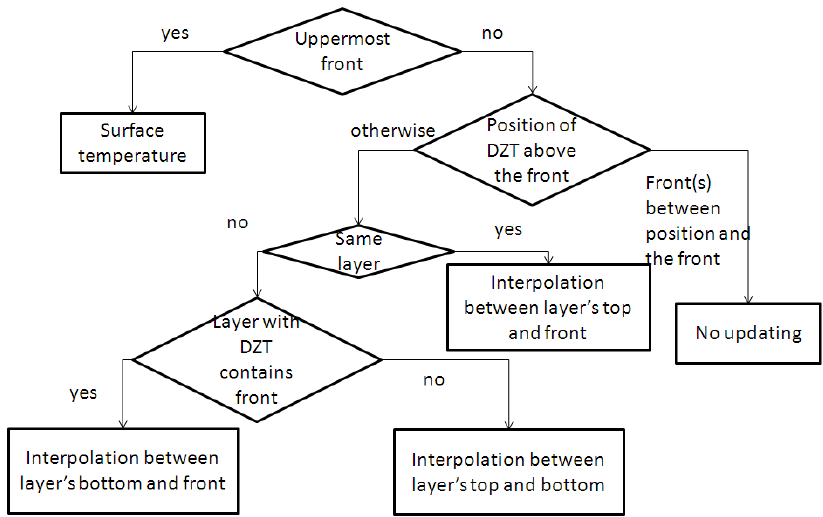
Figure A2. The flowchart for the calculation of upper temperatures for updating the position of the front from above. (Note: front(s) between position and the front in the flowchart means there are front(s) between the front under consideration and the position of